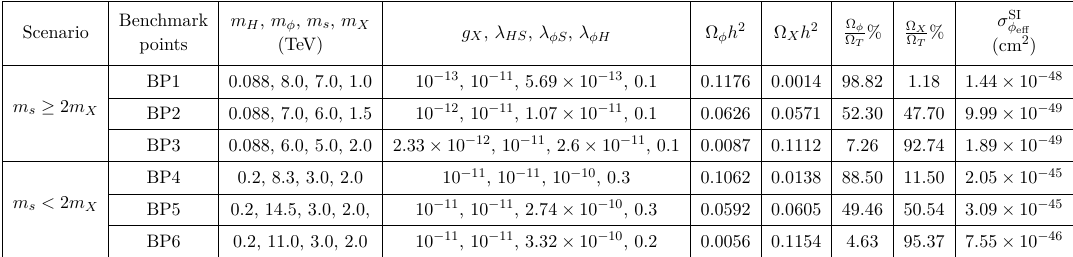
Table 3 . Some sample benchmark points for the WIMP-FIMP model, when both freeze-in of X and freeze-out of φ occur bEWSB respecting the total relic density, direct search, Higgs mass/mixing and other constraints. The benchmark points depict the possibilities when one component dominates over the other as well as the case when they have almost equal share for the total DM relic